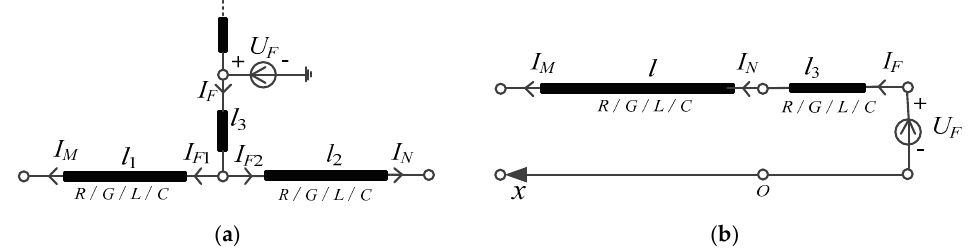
Figure 3. Additional network after fault occurrence with two external observers: ( a ) the connection of fault and health line is between the two observers; ( b ) the fault line connects to the terminals of the health line.